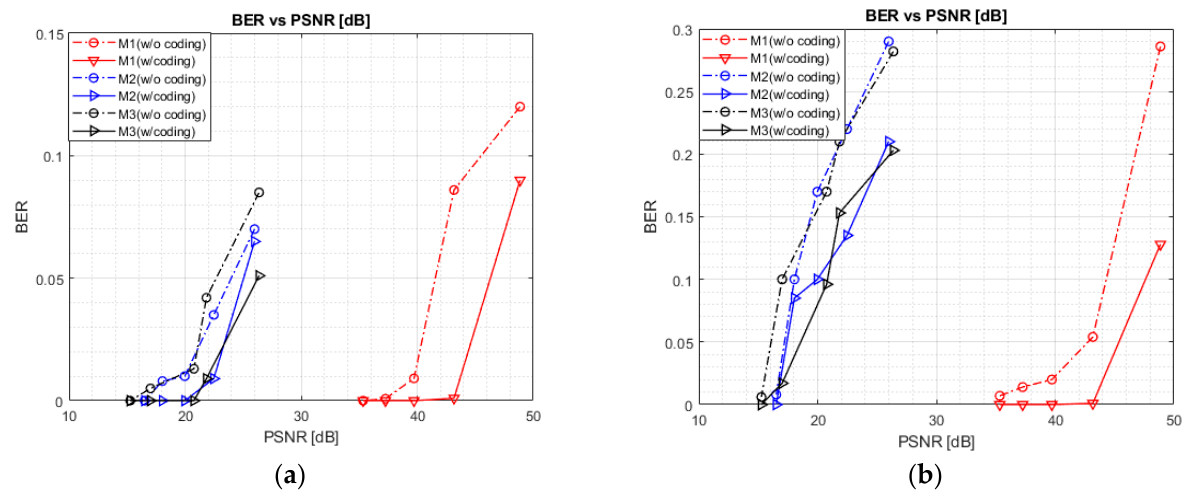
Figure 7. Bit error rate (BER) performance with respect to PSNR [dB], in simulations in which images were rotated at the receiver. ( a ) m = 250 and ( b ) m = 500.